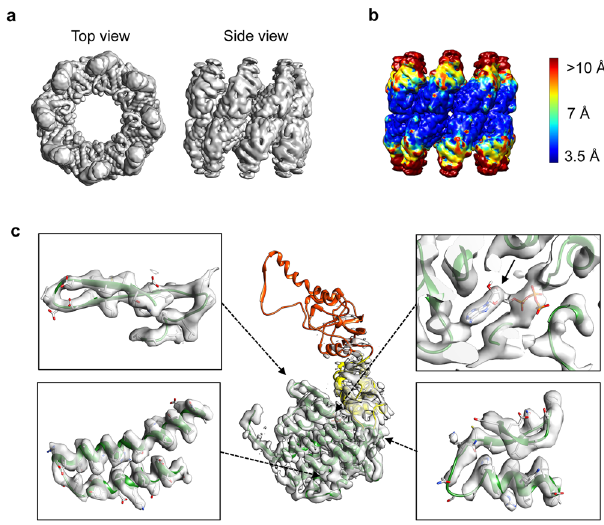
Fig. 1 A 3.9 Å D8 symmetry averaged cryoEM structure of MmCpn in the presence of ATP. a Top and side views of MmCpn cryoEM reconstruction. b Local resolution map calculated by MonoRes 51 . Color key for local resolution (in Å) is shown. c Segmented cryoEM map for a single subunit with the model superimposed. Equatorial, intermediate, and apical domains of the model are colored in green, yellow, and red respectively. High- resolution features in the equatorial domain are shown in side panels, including the ATP binding site (upper right with an